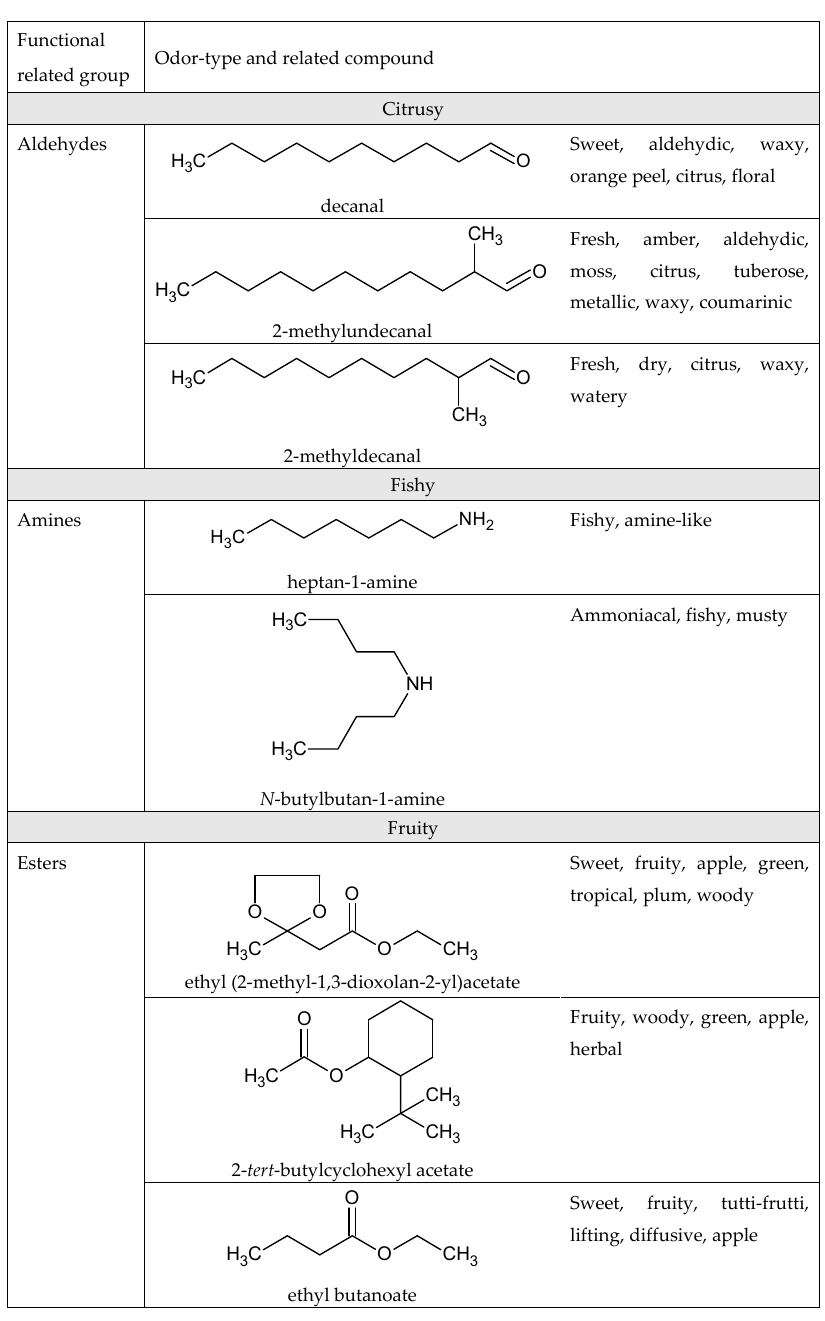
Figure 1. Examples of odorants with common functional groups and similar odors [23].